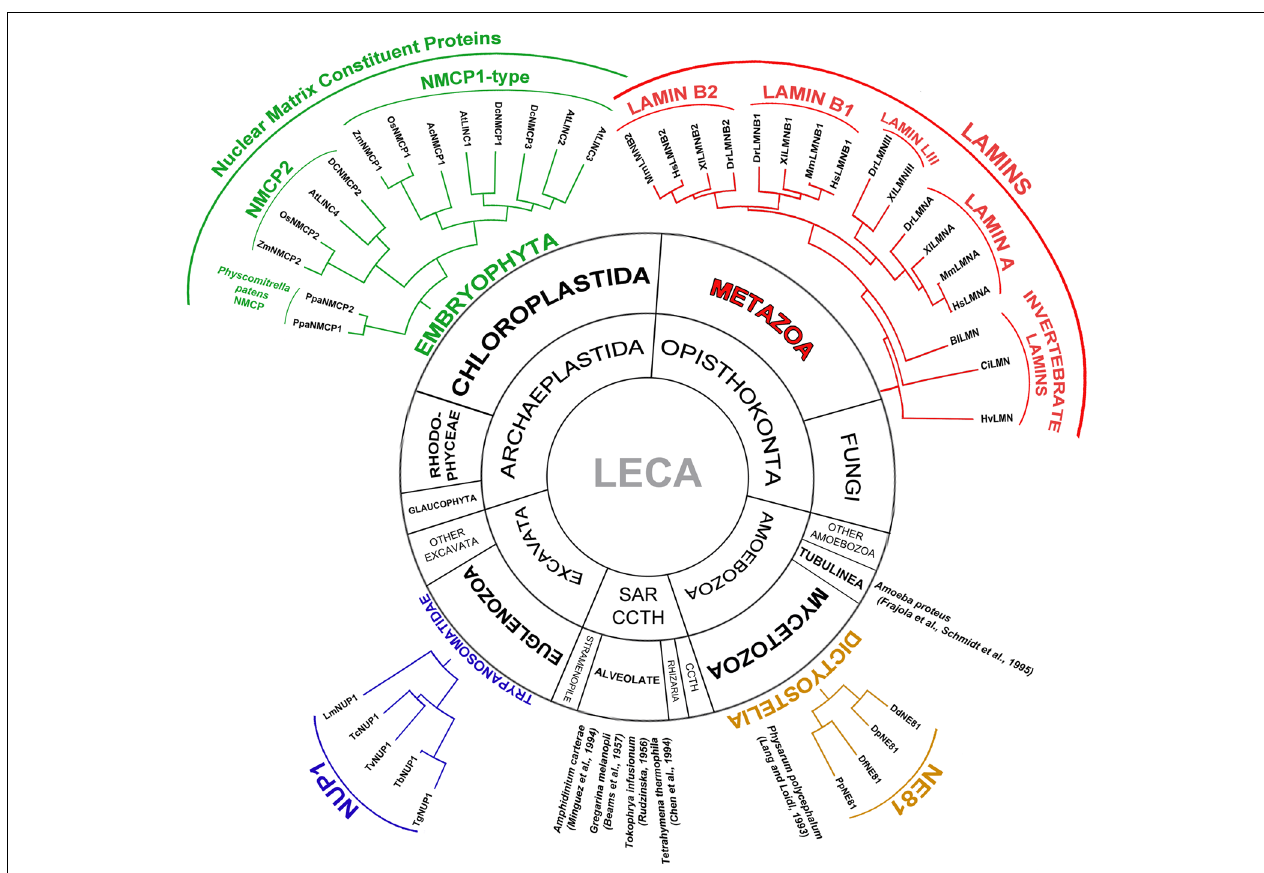
up of nuclear matrix constituent proteins (NMCPs; Masuda etal., 1997; Ciska etal., 2013). NMCPs are classified in flowering plants into NMCP1-type proteins and NMCP2. Monocots have one NMCP1 and one NMCP2 proteins while dicots contain one NMCP2 and two or three NMCP1-type proteins.The moss Physcomitrella patens contains two NMCP proteins (Ciska etal., 2013). Selected species for the representation of the NMCP protein family: Allium cepa (Ac), Arabidopsis thaliana (At), Daucus carota (Dc), Oryza sativa (Os), Physcomitrella patens (Ppa), and Zea mays (Zm); NE81 proteins: Dictyostelium discoideum (Dd), Dictyostelium fasciculatum (Df), Dictyostelium purpureum (Dp), and Polysphondylium pallidum (Pp); NUP1 proteins: Trypanosoma brucei (Tb), Trypanosoma gambiense (Tg), Trypanosoma cruzi (Tc), Trypanosoma vivax (Tv), and Leishmania major (Lm); and lamins: Hydra vulgaris (Hv), Ciona intestinalis (Ci), Branchiostoma lanceolatum (Bl), Danio rerio (Dr), Xenopus laevis (Xl), Mus musculus (Mm), and Homo sapiens (Hs). LECA, the last eukaryotic common ancestor; SAR, stramenopile, alveolate, Rhizaria; CCTH, cryptomonads, centrohelids, telonemids,